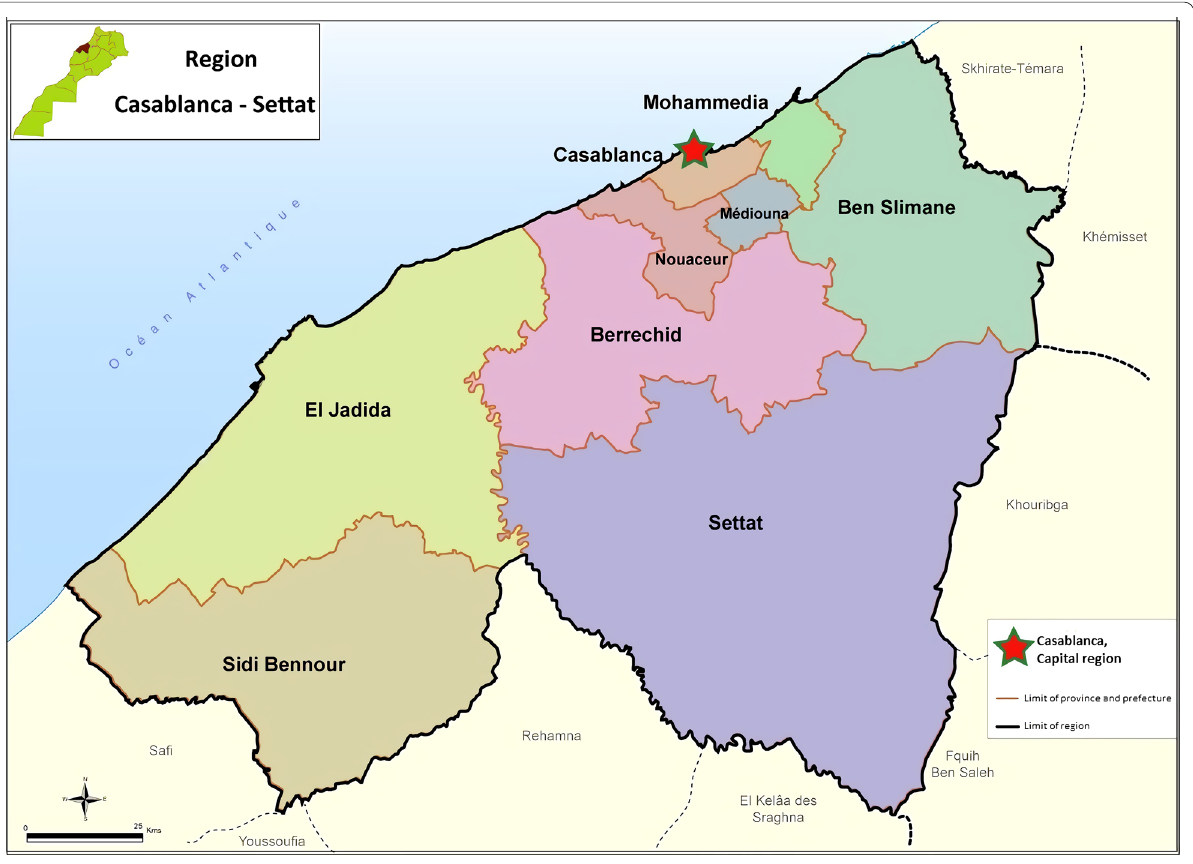
Fig. 1 Map of the Casablanca-Settat region [40]